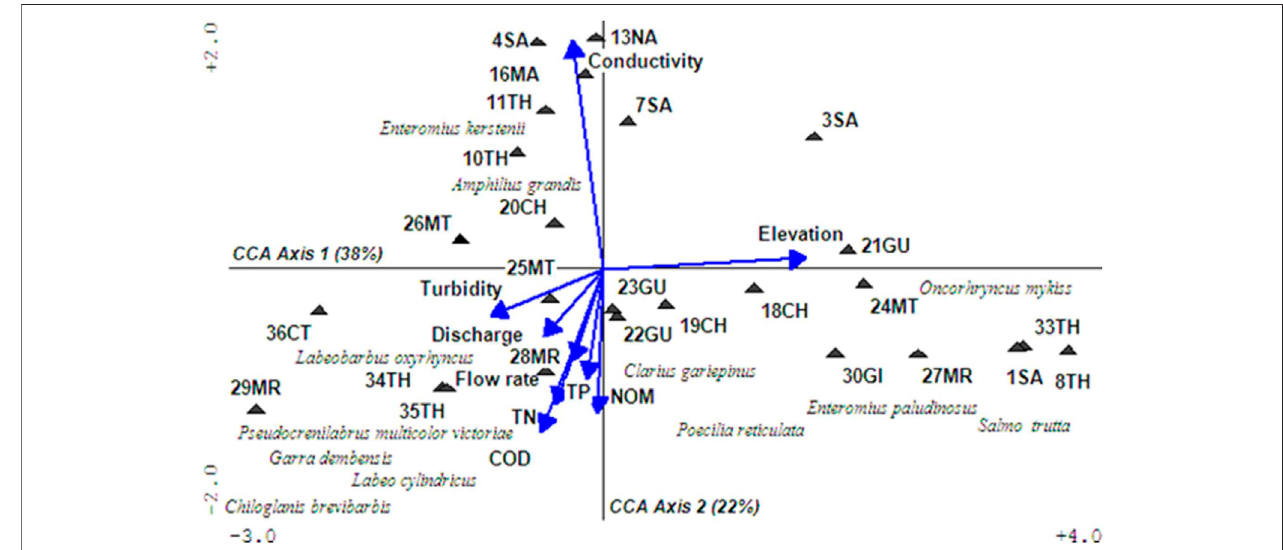
FIGURE 6 | CCA triplot of fi sh and water quality in Upper Tana River Watershed.